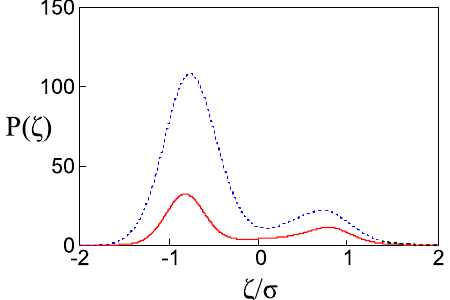
FIG. 5. Effect of the energy spread on the pulse amplitude P (in arbitrary units), ζ = σ is the bunch coordinate. Parameters are the same as Fig. 4(a). In this case the front part of the electron beam exhibits an energy spread 6 times larger than the back part. It is therefore evident that the front part of the bunch (characterized by a larger energy spread) is more significantly depressed. The pulse shape is shown for two positions inside the undulator at